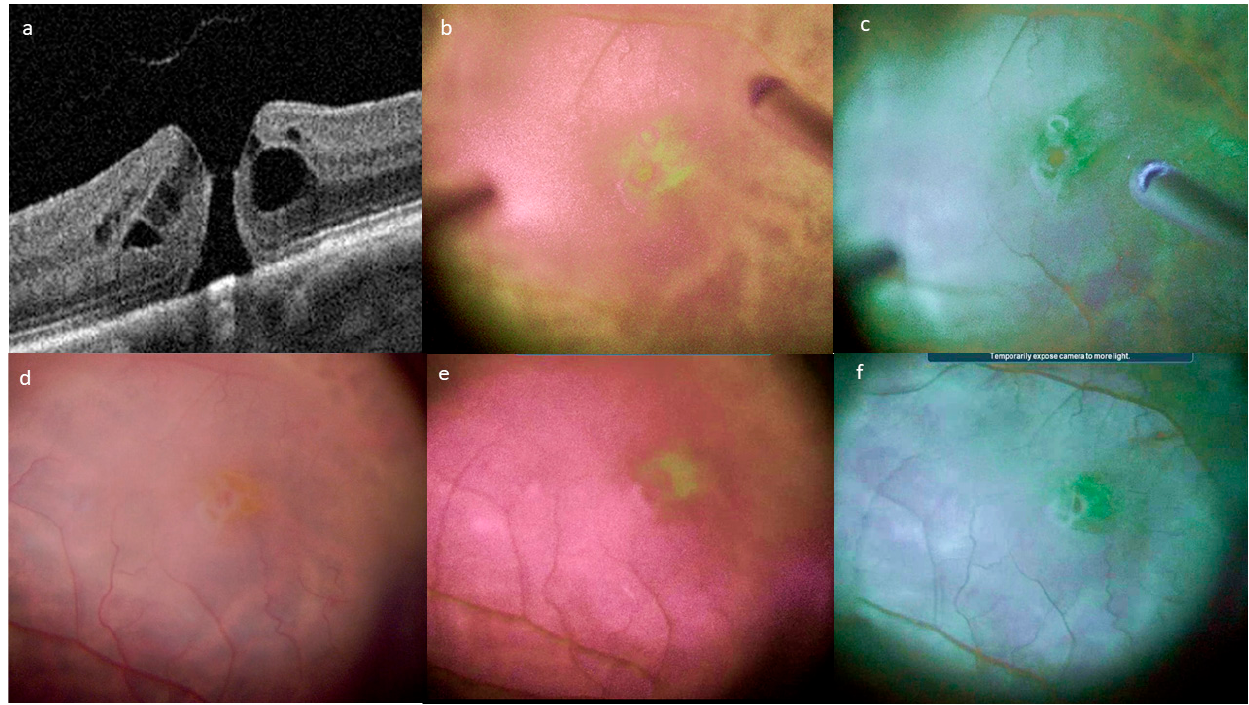
Figure 3. Enhanced visualization of the pigmentation of epiretinal tissue associated with a macular hole. ( a ) Preoperative OCT. Enhancement of pigmented epiretinal tissue with fi lter 1 ( b ) and fi lter 2 ( c ) during peeling. Standard color view ( d ) after positioning of the pigmented epiretinal tissue within the hole after. View after fi lter 1 ( e ) and fi lter 2 enhancement ( f ). For lamellar holes, the fi lters revealed continuity of the MP in the lamellar hole area. They enhanced the visualization of the epiretinal proliferation associated with these la- mellar holes. In epiretinal membrane surgery, the fi lters showed that the integrity of the MP was maintained at the end of surgery in all cases (Figure 1). The peeled ILM over the fovea was homogeneous without enhancement with digital MP fi lters. 4. Discussion High concentrations of MP are normally present in the macula area, and various as- pects of MP disruption in retinal diseases have been described. In clinical practice, MP can be enhanced and evaluated using the two-wavelength fundus auto fl uorescence technique [5,6]. Here, we provide the fi rst report of the digital enhancement of MP visualization during surgery. The main features of the optimized se tt ings used in our study to enhance MP visual- ization were increases in cyan and yellow saturation and the use of a magenta-green fi lter. Increasing cyan color saturation in the cyan-red channel decreased the color temper- ature of the warm colors, close to red, in the image [16], thereby highlighting the xantho- phyll pigment. Yellow color saturation was also increased to highlight the yellowish color of the MP. Blending of cyan and yellow colors typically results in a green color, which we observed intraoperatively with the use of these cyan and yellow fi lters. The magenta-green fi lter was the third component of the optimized se tt ings, and its use di ff erentiated between fi lters 1 and 2 in this study. Increasing magenta color satura- tion ( fi lter 1) resulted in the MP appearing clearly green and slightly fl uorescent. In terms of color temperature, magenta is complementary to green, with complementary colors de fi ned as the colors with the largest contrast between them [17]. Decreasing magenta saturation ( fi lter 2) decreased MP enhancement but increased the quality of the retinal